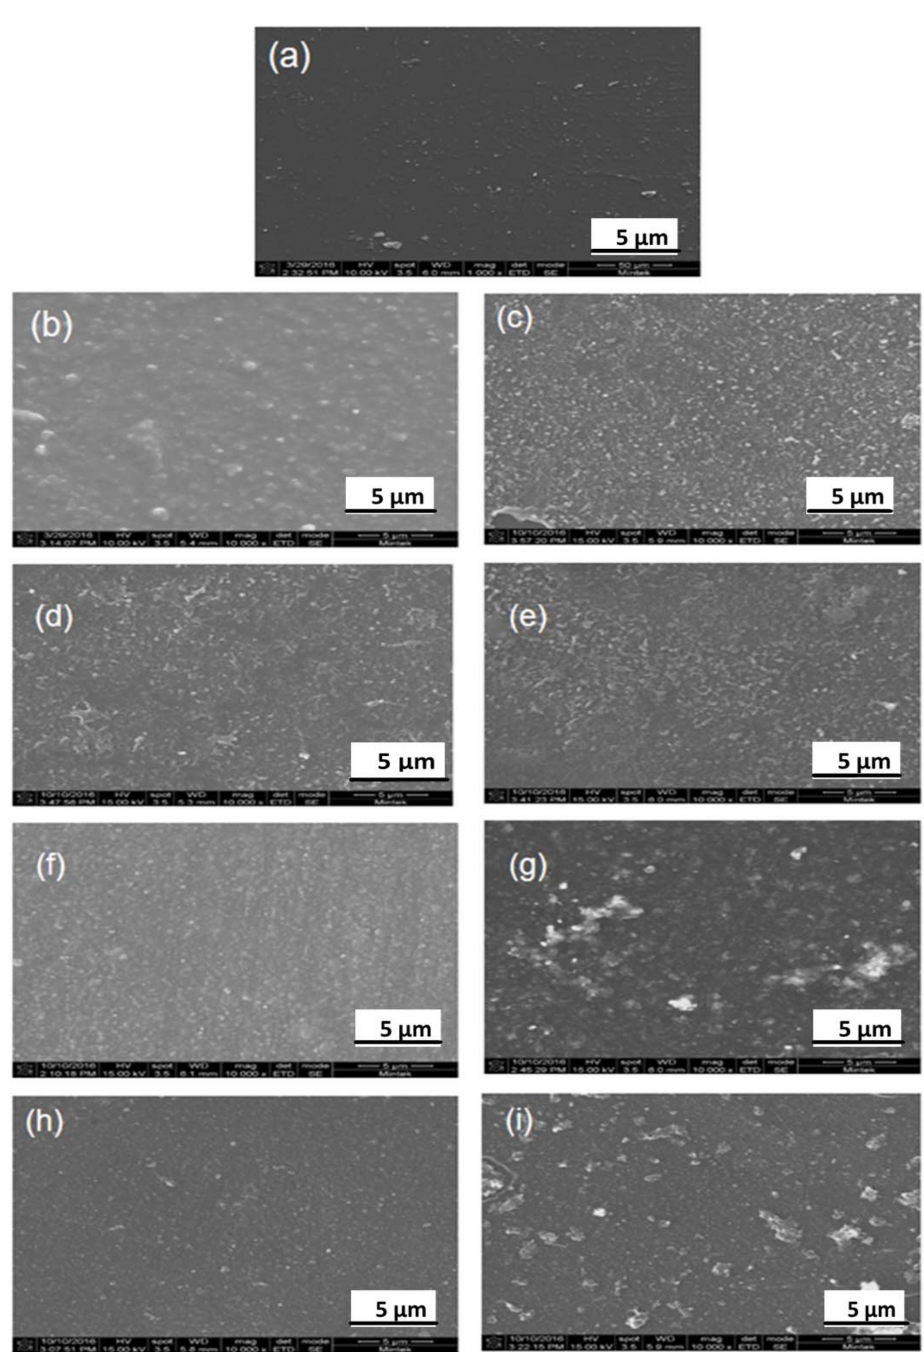
Figure 3. SEM images of: ( a ) unmodified membranes; and membranes modified with: ( b )